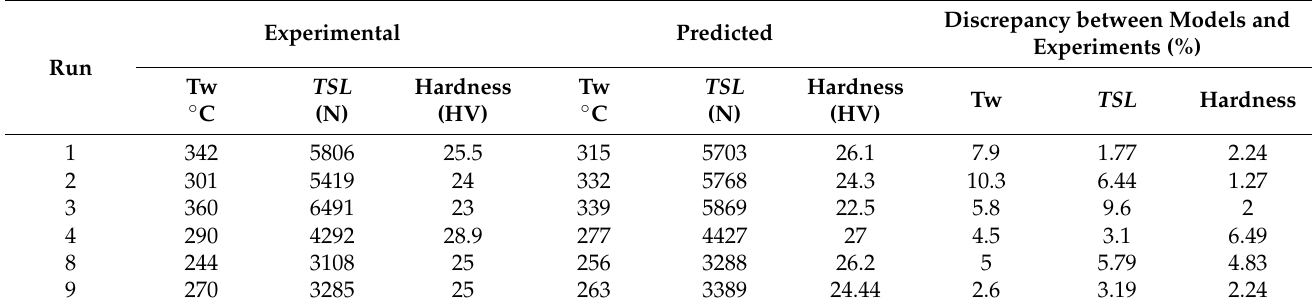
Table 14. The soundness of the developed